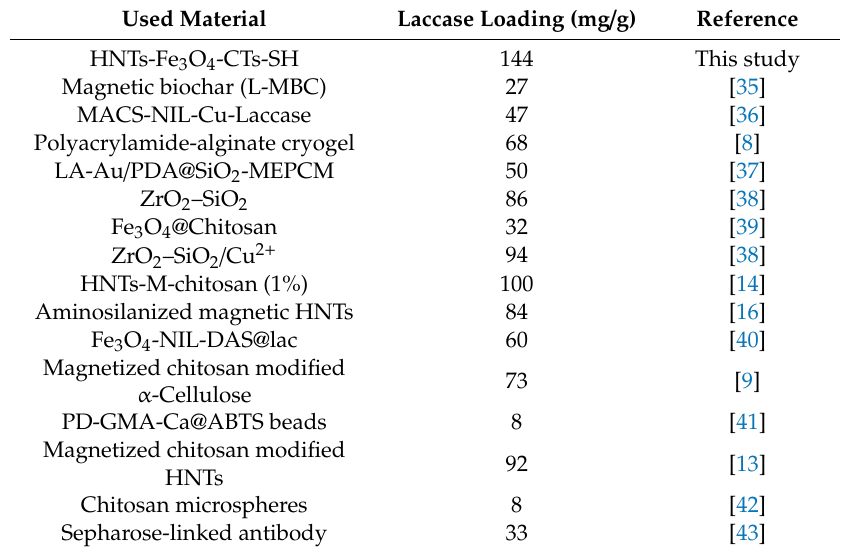
Table 1. Laccase loading capacity (mg / g) comparison of the recently reported